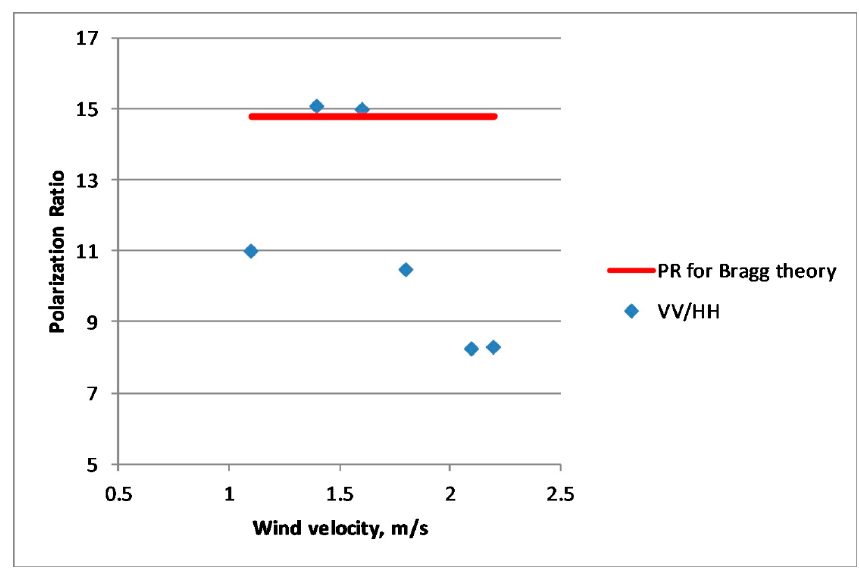
Figure 8. Polarization Ratio (PR) as a function of wind velocity. The red line denotes PR for the Bragg theory.